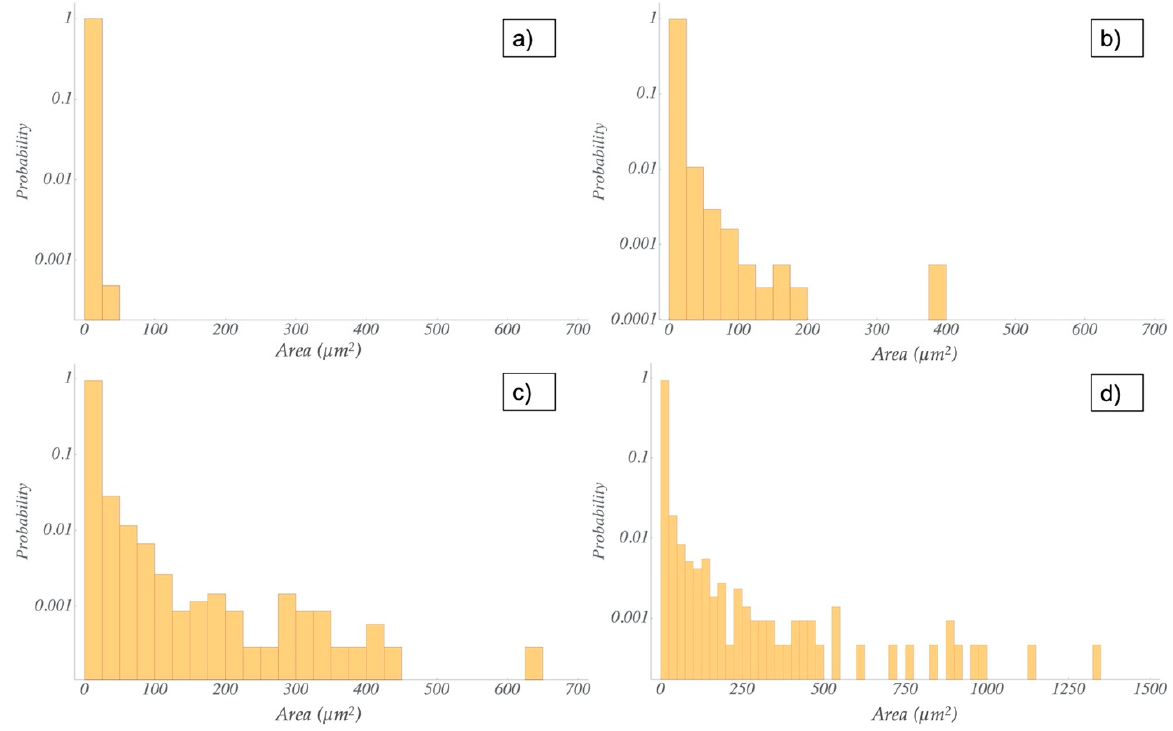
Figure 5. Comparison of the distribution of agglomerate area size for the TRM dispersion for the 0.5 wt% filler grade and different fillers: ( a ) CNF; ( b ) CNToxi; ( c ) CNT; ( d ) CNT semi.